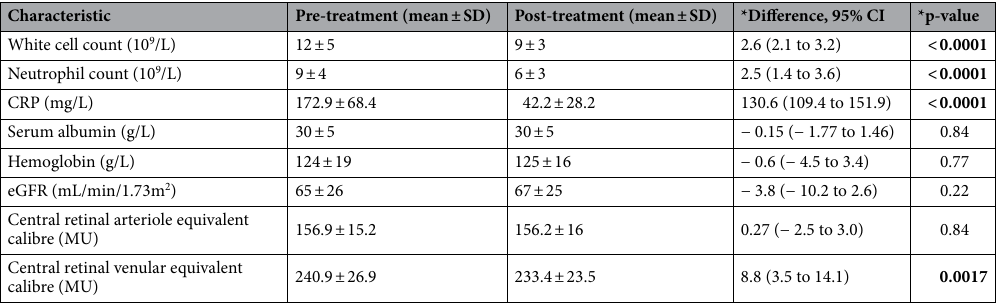
Table 2. Characteristics at recruitment and after CRP levels fell to < 100 mg/L. Results in bold where p < 0.05. CRP C-reactive protein. *By two-tailed paired t